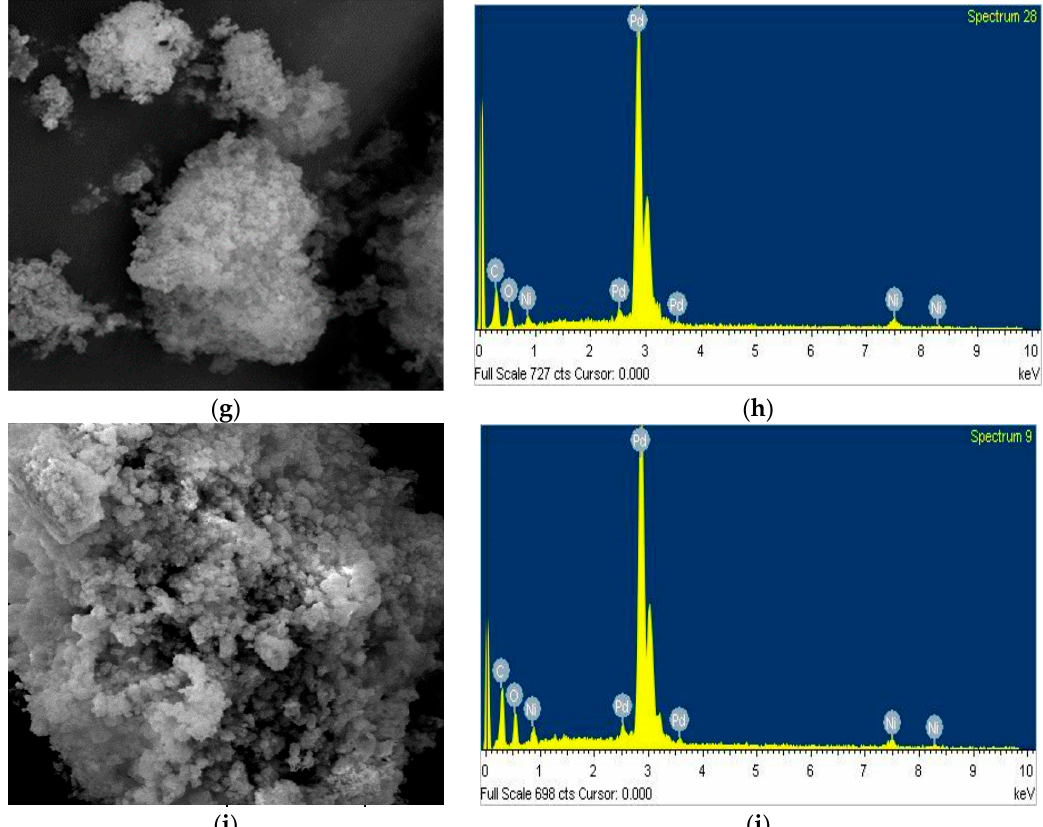
Figure 3. Scanning electron microscopy (SEM) images for the synthesized binary palladium PdNi x alloys ( a ) PdNi 1 , ( c ) PdNi 2 , ( e ) PdNi 3 , ( g ) PdNi 4 , ( i ) PdNi-rGO, Energy dispersive spectroscopy (EDS) images for ( b ) PdNi 1 , ( d ) PdNi 2 ( f ) PdNi 3 , ( h ) PdNi 4 , ( j ) PdNi-rGO.